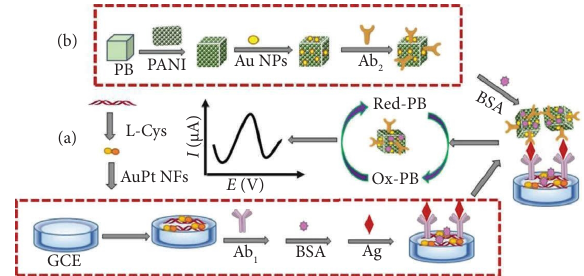
Scheme 1: (a) Te construction process of electrochemical immunosensor. (b) Assembly diagram of